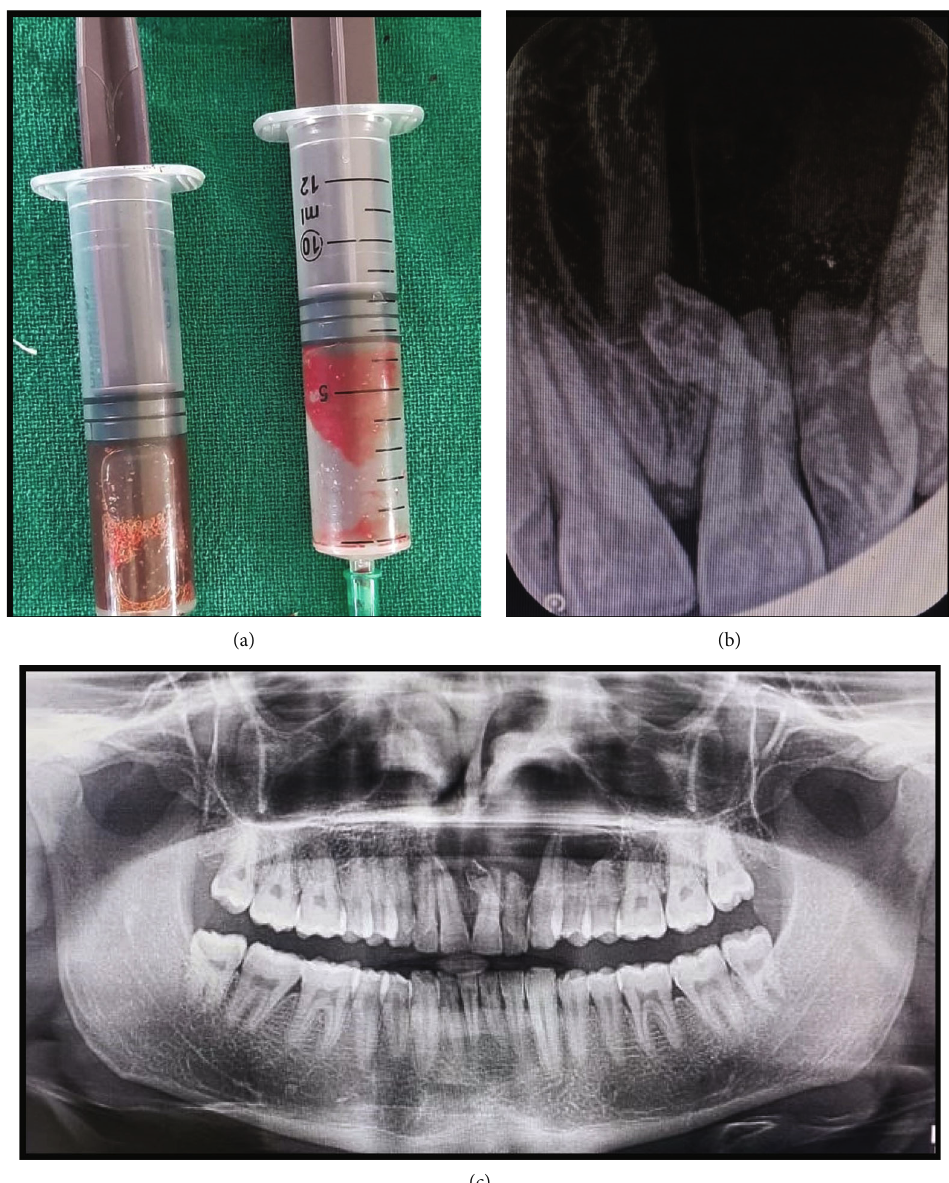
Figure 2: (a) Fine-needle aspiration revealed yellow-brown, blood-tinged cystic aspirate. (b) and (c) IOPAR and OPG demonstrate a well- de fi ned unilocular radiolucency with an impacted inverted mesiodens in the maxillary anterior